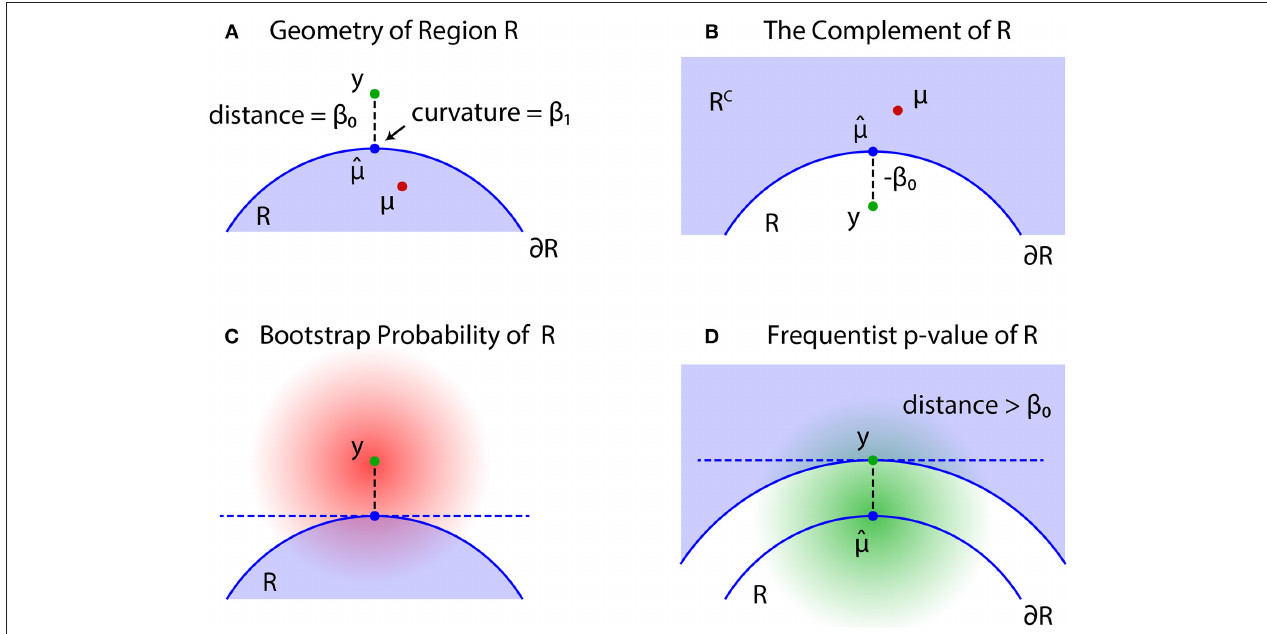
FIGURE 4 | Problem of regions. (A) β 0 > 0 when y ∈ R C , then select the null hypothesis µ ∈ R . (B) β 0 ≤ 0 when y ∈ R , then select the null hypothesis µ ∈ R C . (C) The bootstrap distribution of Y ∗ ∼ N m + 1 ( y , I m + 1 ) (red shaded distribution). (D) The null distribution of Y ∼ N m + 1 ( ˆ µ , I m + 1 ) (green shaded